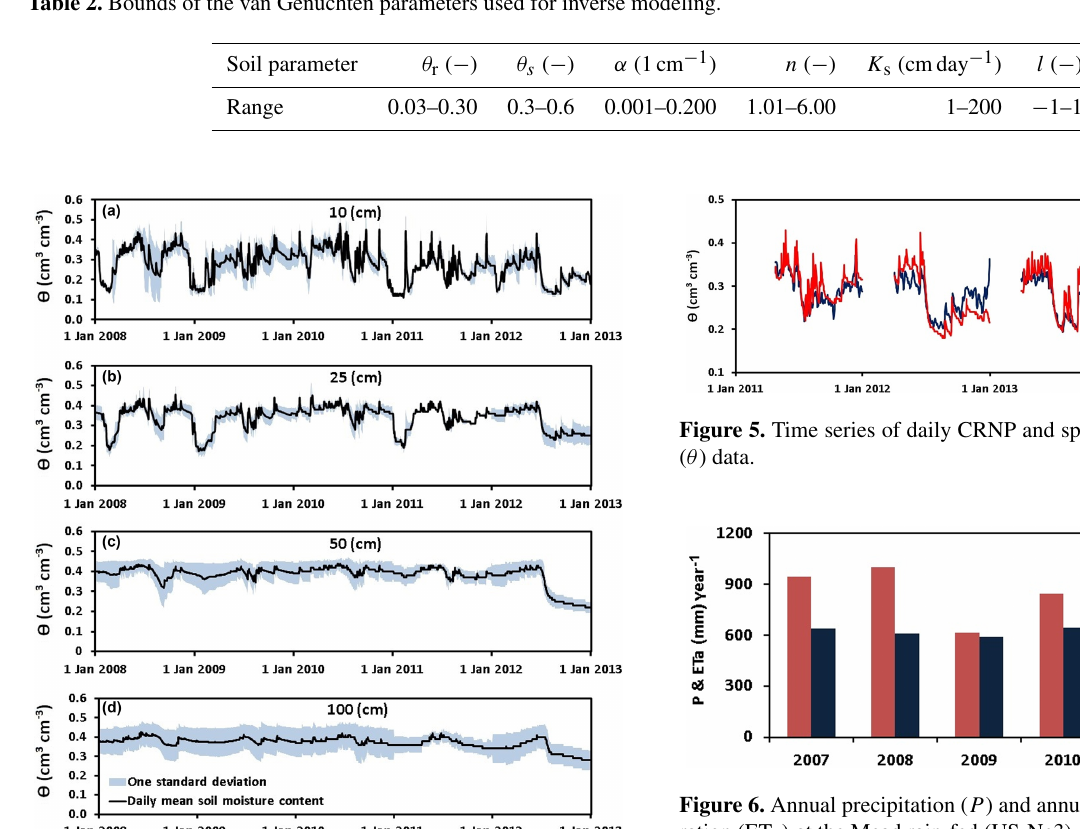
Table 2. Bounds of the van Genuchten parameters used for inverse modeling.